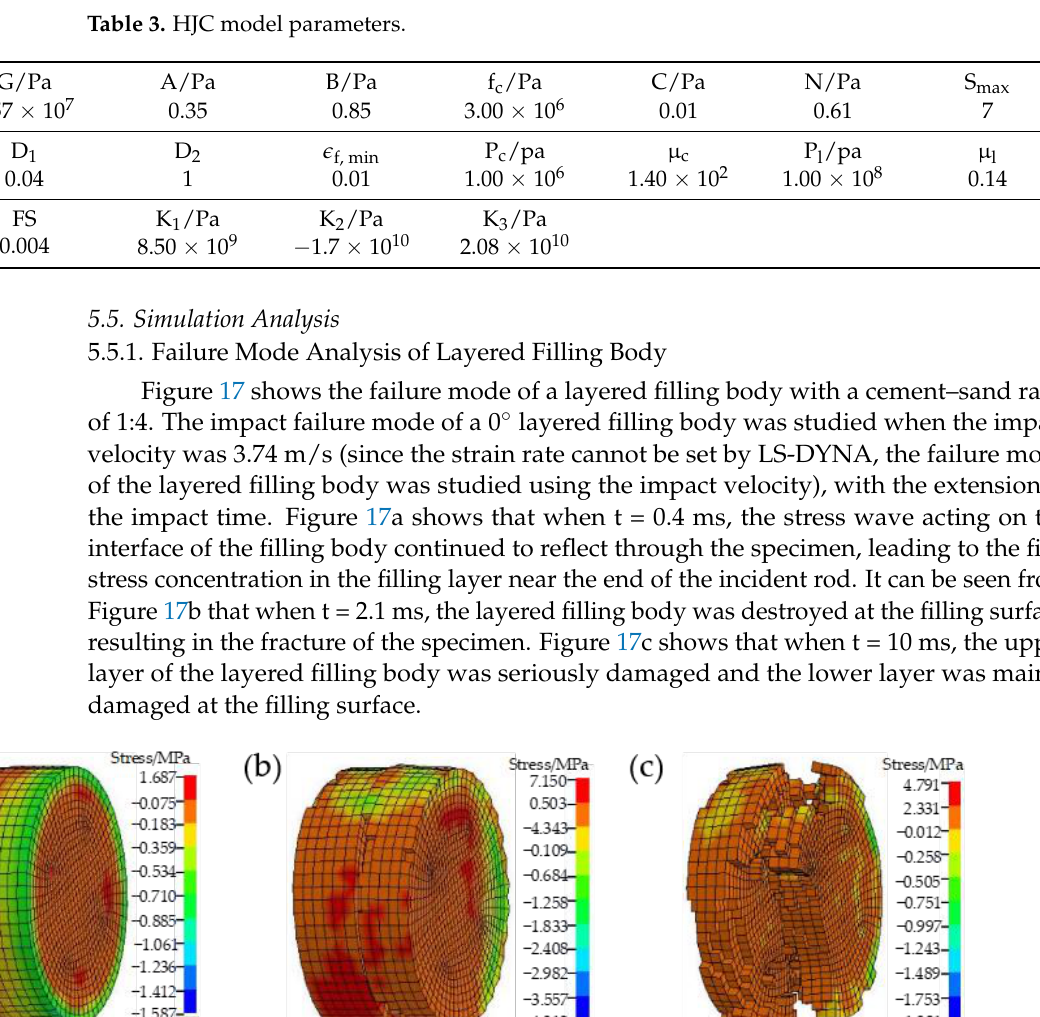
Figure 18. Stress distribution nephogram of 13° layered filling body: ( a ) failure time of 0.6 ms; ( b ) failure time of 1.1 ms; ( c ) failure time of 9.4 ms. 5.5.2. Analysis of Simulated Stress – Strain Curve of Layered Filling Body As shown in Figure 19, the simulated stress – strain curve had stronger regularity than the experimental stress – strain curve. When the impact rate was 4.97 m/s and the filling surface angle was 0°, the dynamic peak strength of the layered filling body was 7.00 MPa. When the filling surface angle was 5°, the dynamic peak strength of the layered filling body was about 5.98 MPa. When the filling surface angle was 13°, the dynamic peak strength of the layered filling body was about 4.92 MPa, which was similar to the experi- mental peak strength. This indicates that the dynamic peak strength of layered backfill decreases gradually with the increase in the filling surface angle.